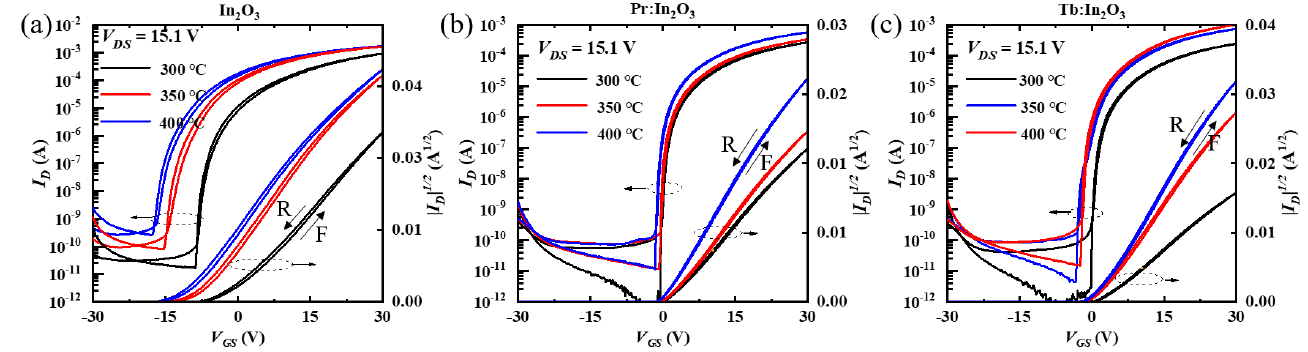
Figure 2. Transfer curves of the ( a ) In 2 O 3 , ( b ) Pr:In 2 O 3 TFTs, and ( c ) Tb:In 2 O 3 TFTs; all of the curves recorded both forward (F) and reverse (R) gate sweeps.